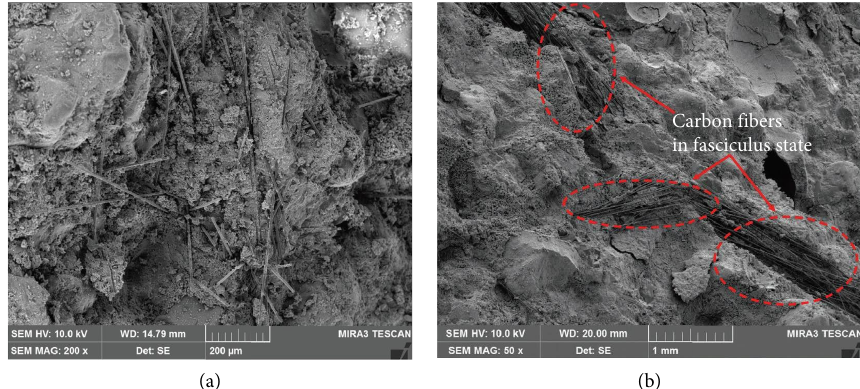
Figure 6: Morphology of the fracture surfaces of the CFRCC specimens. (a) Good dispersion of CF (200x) and (b) poor dispersion of CF (50x).